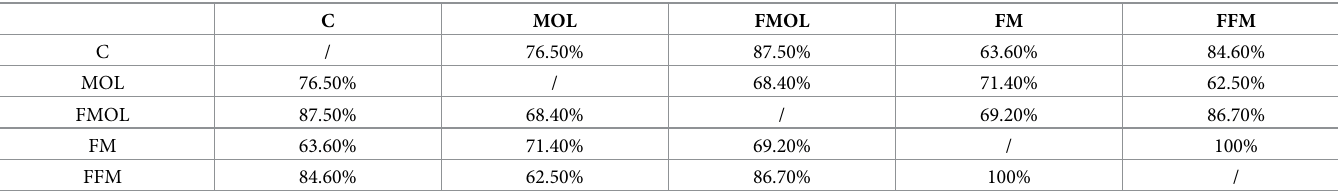
Table 4. The dissimilarity of bacteria community associated with different feed groups.